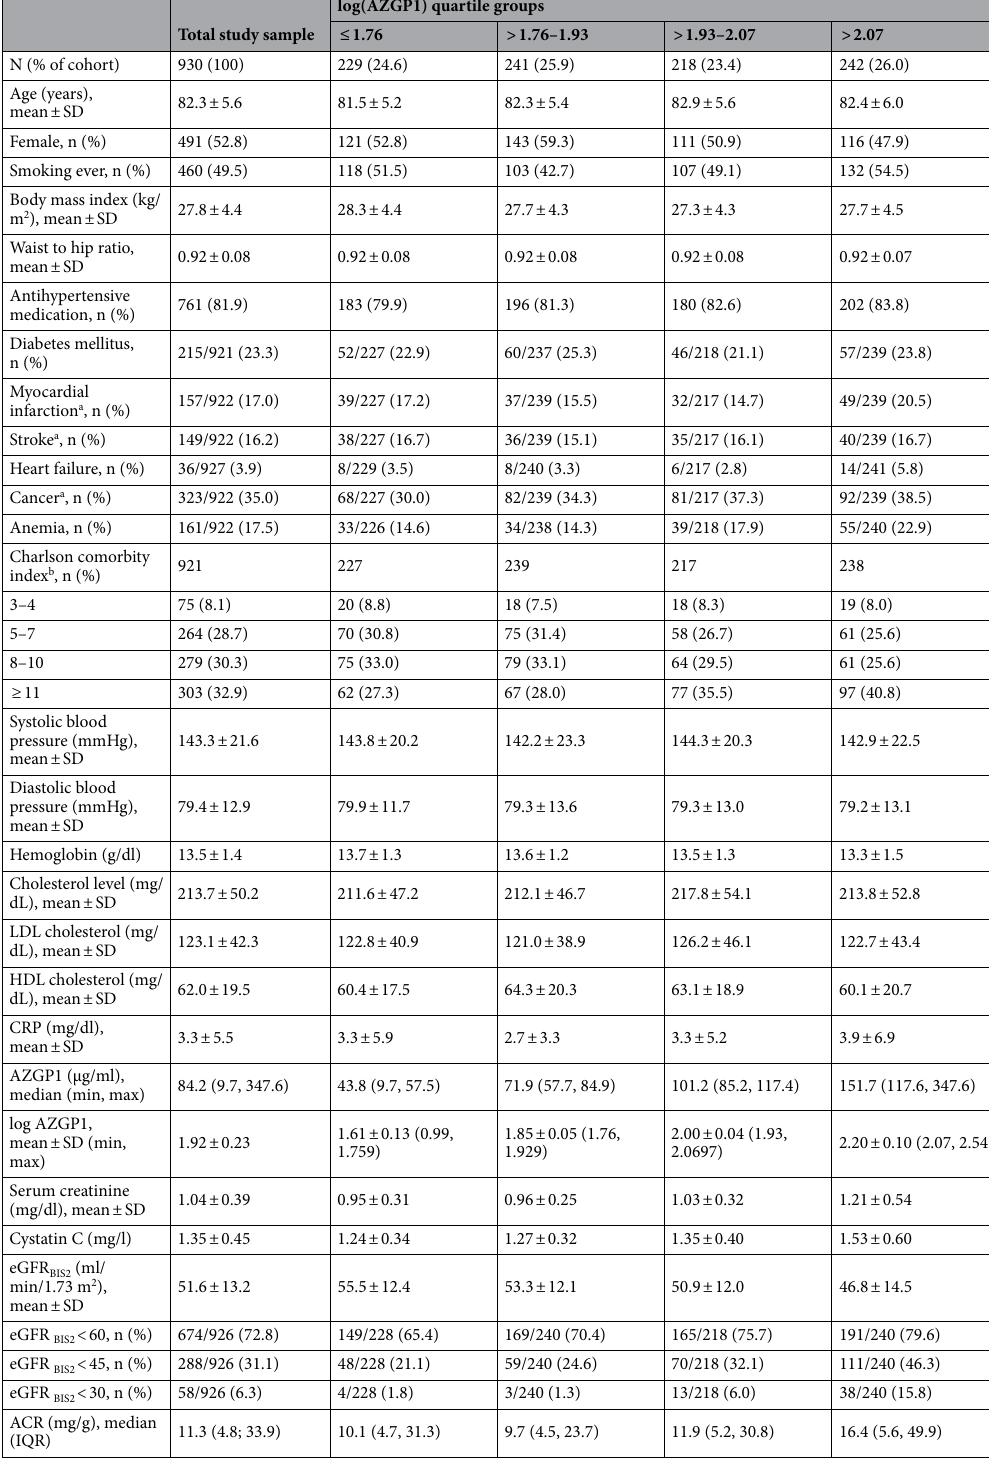
Table 1. Baseline characteristics of total study sample and according to log-transformed AZGP1 levels in older adults. ACR albumin creatinine ratio, CRP c-reactive protein, eGFR estimated glomerular filtration rate, HDL high-density lipoprotein, LDL low-density lipoprotein. a Myocardial infarction, stroke and cancer were derived from insurance claims data based on ICD-10 codes. b Since for the age-adjusted Charlson comorbidity index no established grouping is available, classification was based on survival differences of patients according to the combined age-comorbidity score of the validation paper 40 ; the remaining category “ > 7” was split into two further groups of similar size for better